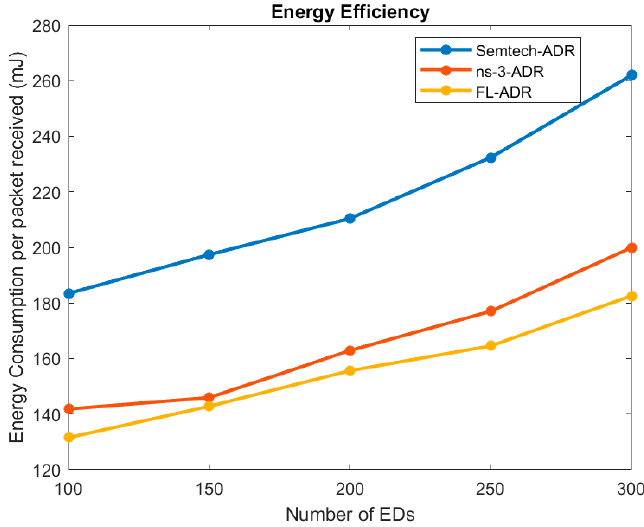
Figure 10. Energy Efficiency in terms of correctly received packets.